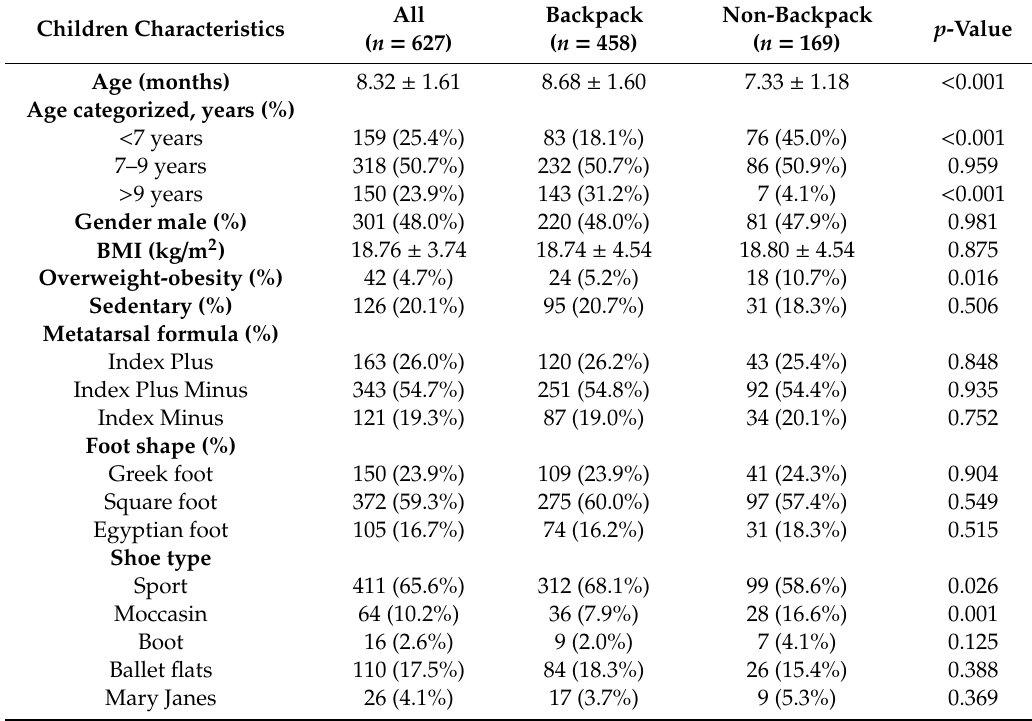
Table 1. Biological, anthropometric, sociocultural and foot characteristics of the children stratified by backpack